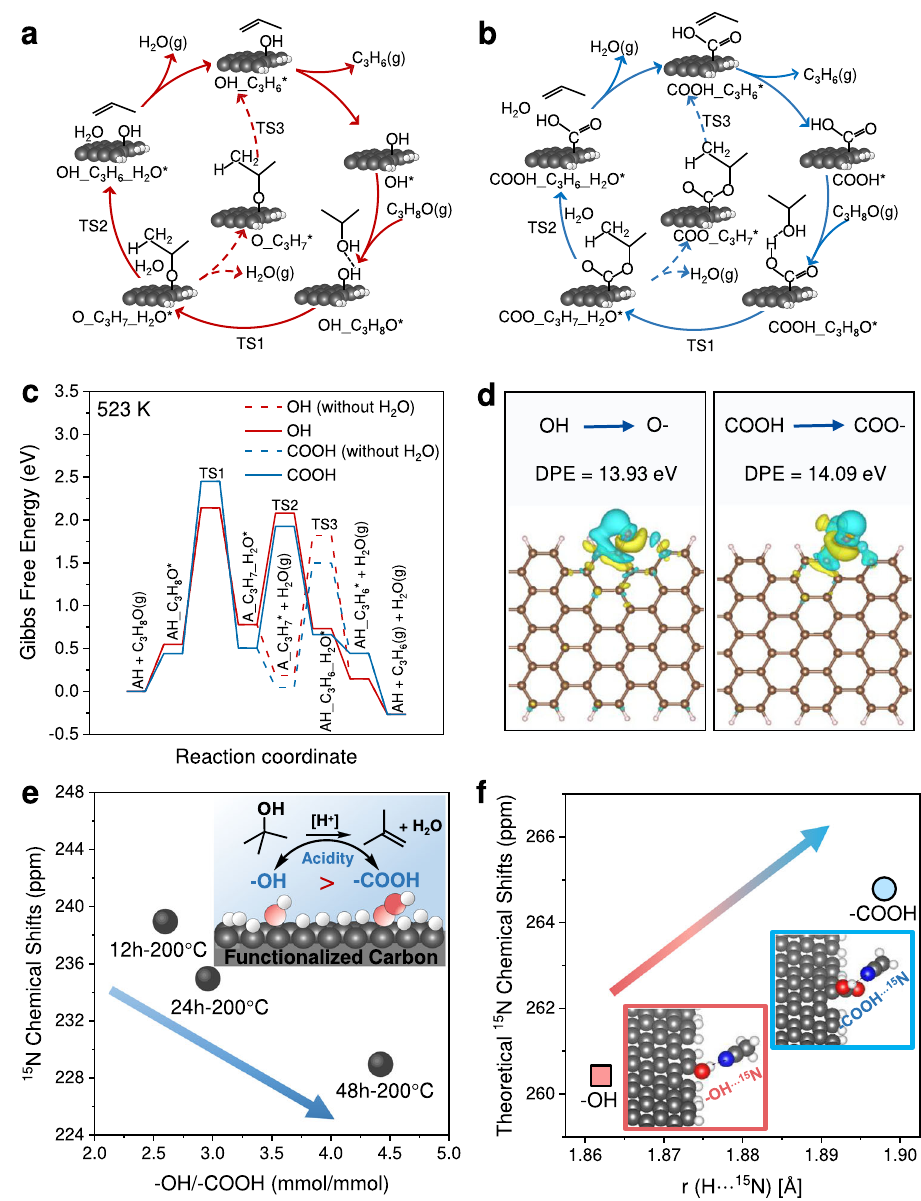
Fig. 4 | Reaction pathways of IPA dehydration on the on acidic OCFGs and strength of acidity. IPA dehydration pathways at a – OH and b – COOH. c Corresponding Gibbs free energy pro fi les at 523K (Brønsted acid site and con- jugatebasedenotedbyAHand A,respectively). d